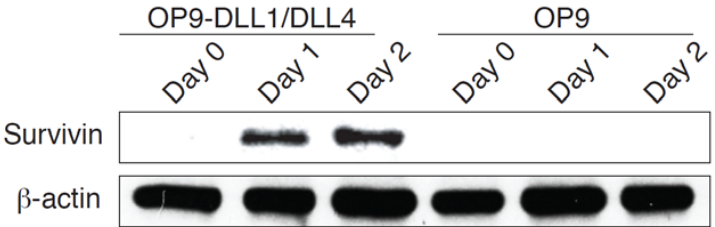
Figure 4. Notch signaling affects survivin expression during HSC ‐ T cell differentiation. The bone marrow ‐ derived CD117 + HSCs from OT ‐ I TCR transgenic mice were co ‐ cultured with OP9 ‐ DLL1/DLL4 or OP9 cells. HSC ‐ derived cells were isolated by gentle repetitive pipetting and centrifuging of the pipetting cells. Expressions of survivin and β‐ actin were analyzed by immunoblot. Data shown are representative of three identical experiments.